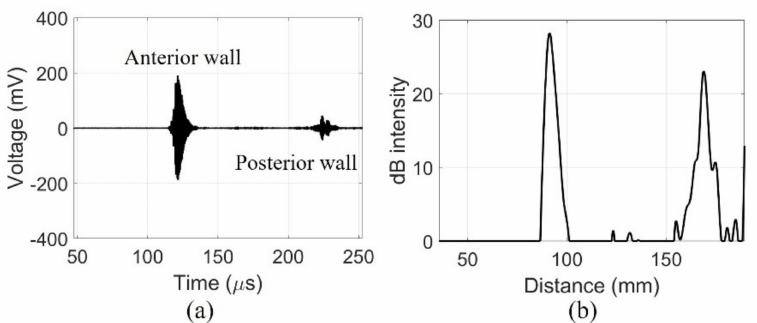
Figure 9. Echo signal received by a single element of fabricated device centrally in the 300 mL of water-injected pig bladder: ( a ) filtered data and ( b ) dB